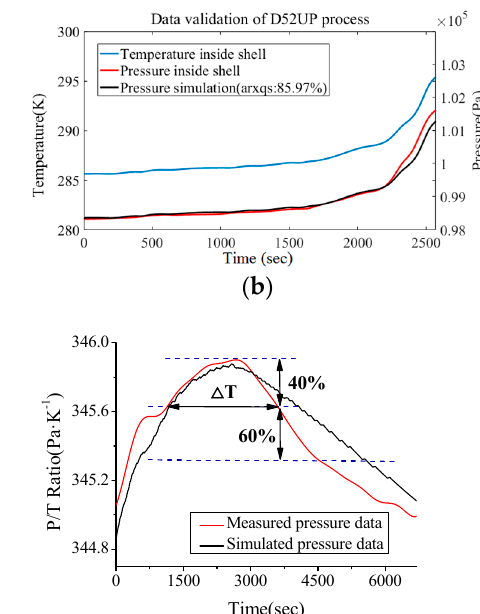
( a ) Comparison for diving profile measurement process of #52 ROV task. ( b ) Comparison for floating profile measurement process of #31 ROV task. ( c ) Comparison for floating profile measurement process of #35 ROV task. ( d ) Trend of P / T c during diving profile process of #52 ROV task. ( e ) Trend of P / T c during floating profile process of #31 ROV task. ( f ) Trend of P / T c during floating profile process of #35 ROV task.